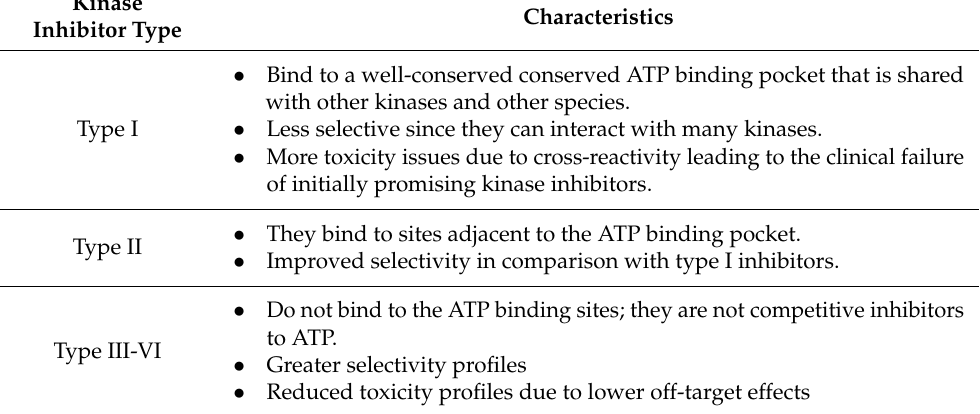
Table 6. Types of kinase